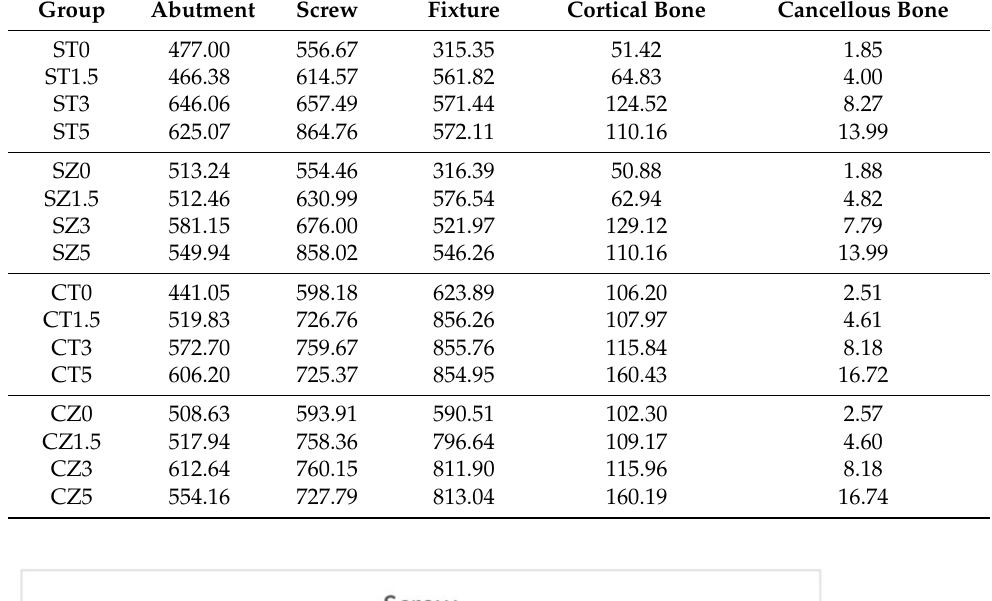
Table 4. Maximum von Mises stress (MPa) on the components of the 16 models. Group